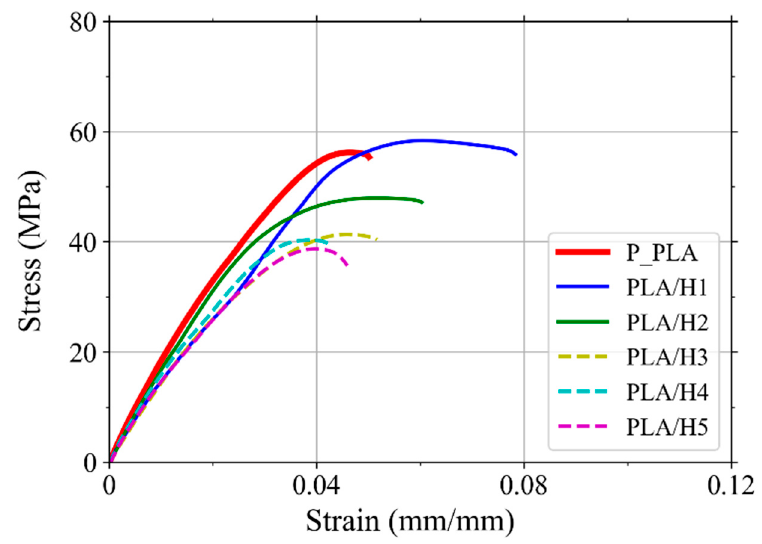
Figure 7. Average tensile stress–strain curves of 3D printed PLA and NFRCs with different contents of henequen flour.